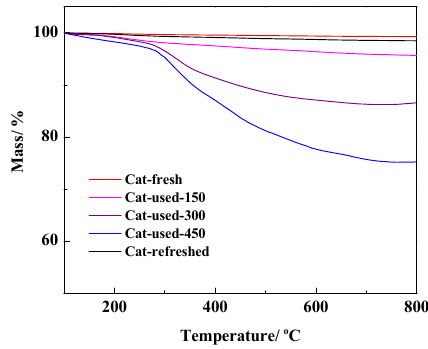
Figure 4. Thermogravimetric analysis of catalysts.